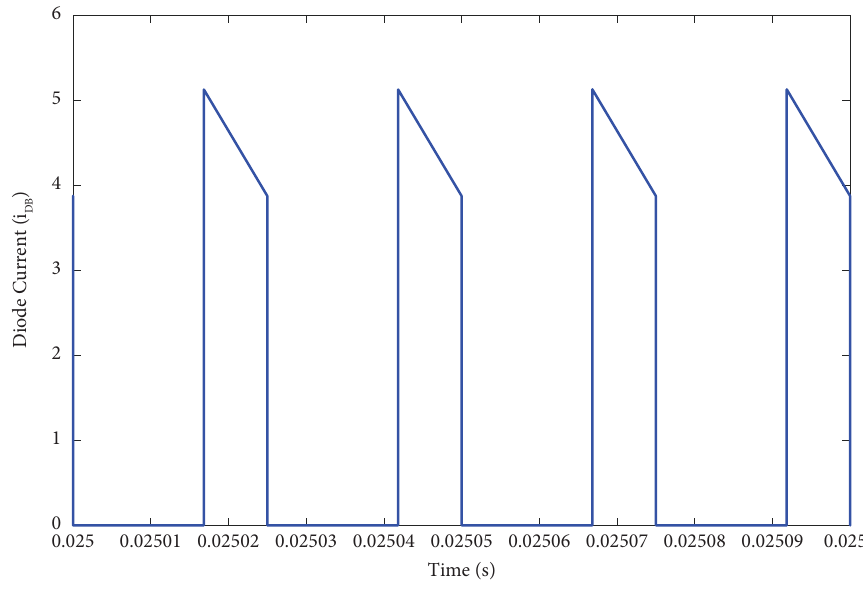
Figure 14: Te diode D A simulated current waveform.